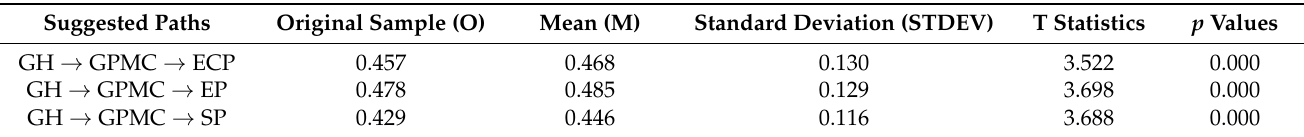
Table 7. Specific indirect